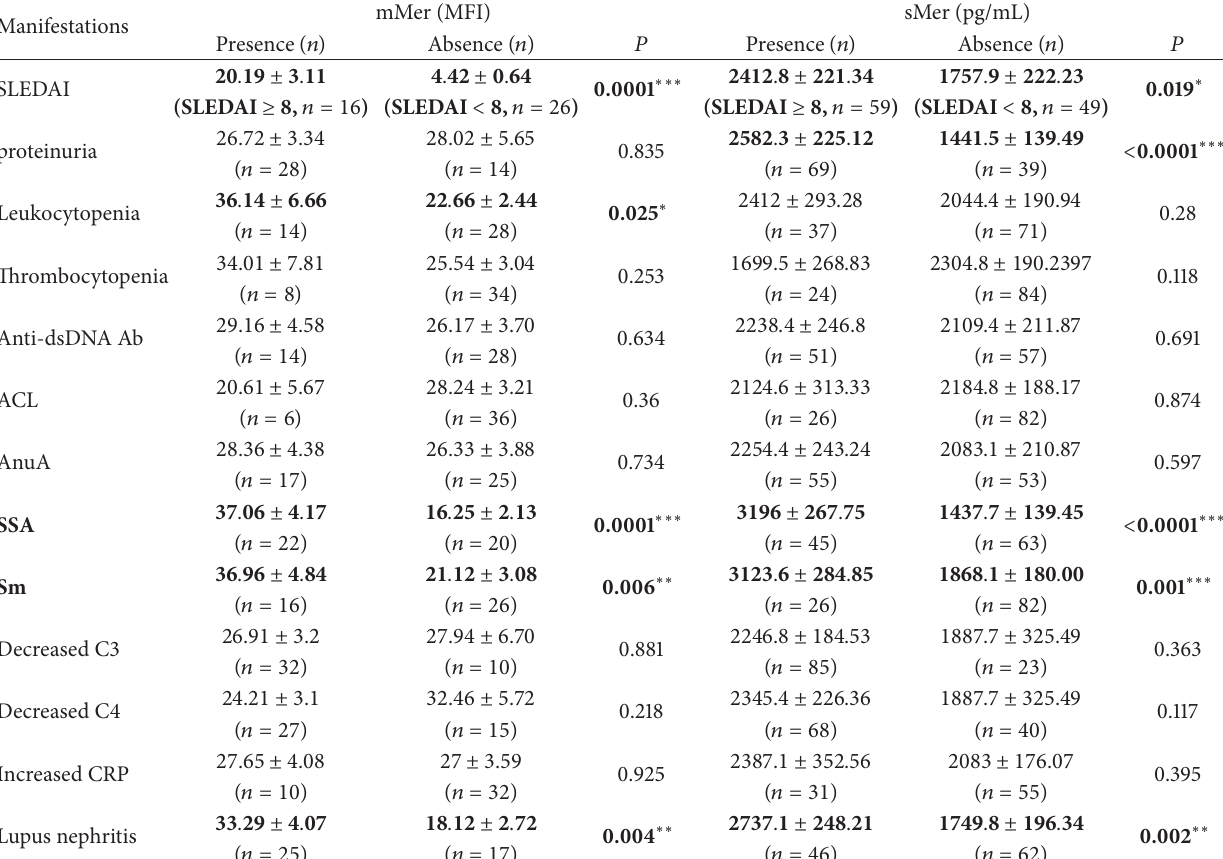
SLE:systemiclupuserythematosus;SLEDAI:systemiclupuserythematosusdiseaseactivityindex;mMer:membraneMertyrosinekinase;sMerTK:solubleMer tyrosine kinase; MFI: mean fluorescence intensity; Anti-dsDNA Ab: anti-double strand DNA antibody; ACL: anticardiolipin antibody; AnuA: antinucleosome antibody; SSA: anti-SSA antibody; Sm: anti-Sm antibody; C3: Complement component 3; C4: Complement component 4. CRP: C-reactive protein. An independent Student’s 𝑡 -test was used for statistical comparison of mMer and sMer levels between the presence and absence of manifestations group in SLE. ∗ 𝑃 < 0.05 , ∗∗ 𝑃 < 0.01 , and ∗∗∗ 𝑃 < 0.001